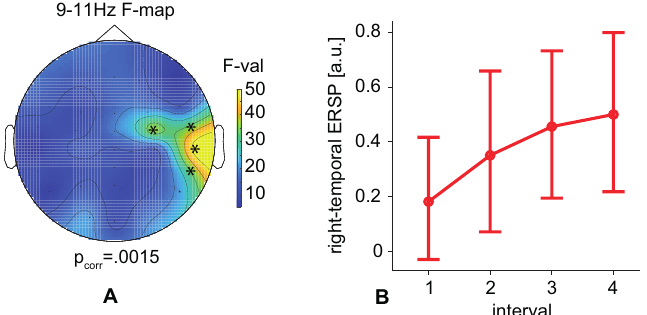
Figure 3. Results of the EEG data analysis on the sensor level: A scalp topogram illustrates F -value and EEG channels cluster, demonstrating the significant change of ERSP between four intervals ( ∗ p = 0.0015 via F -test and cluster-based correction for multiple comparisons) ( A ). Changing ERSP in this cluster (group mean ± 95% CI) with the time with the interval number ( B ).